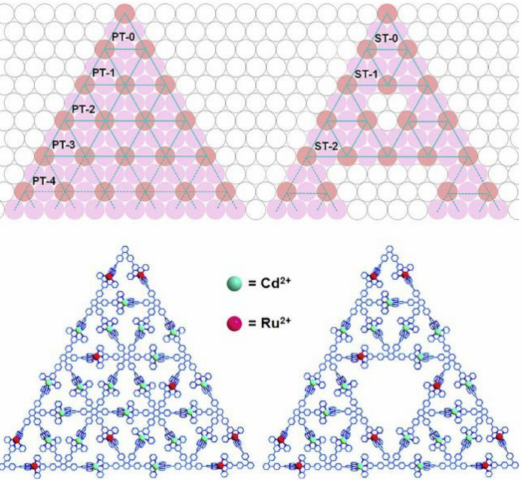
Figure 1. Sierpi´nski Triangular